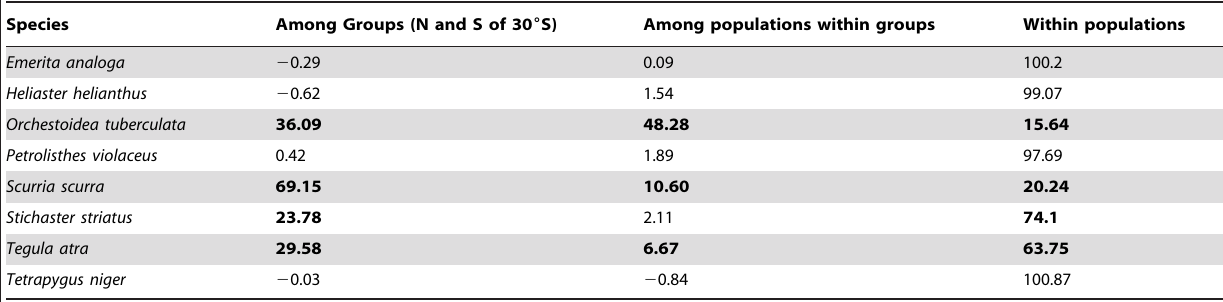
Table 4. AMOVA for all